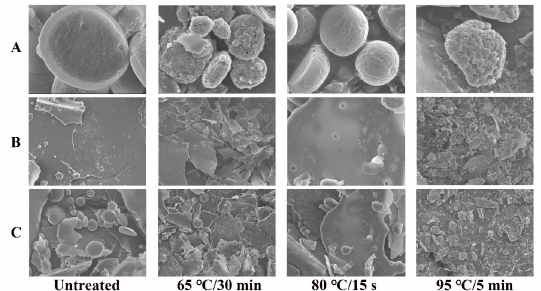
Figure 3. Effects of different sterilizations on the microstructure of WPI by SEM. The magnification is ×30,000 ( A ), ×2000 ( B ), and ×5000 ( C ), respectively.